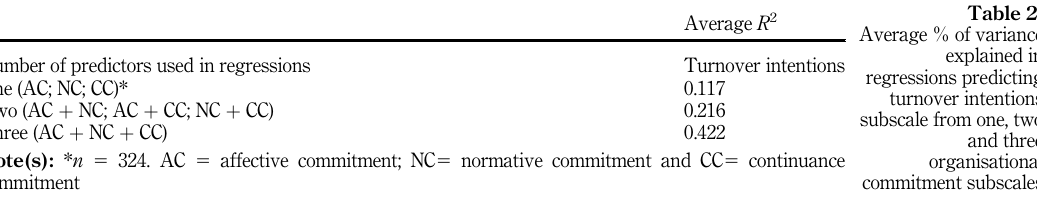
Table 2. Average % of